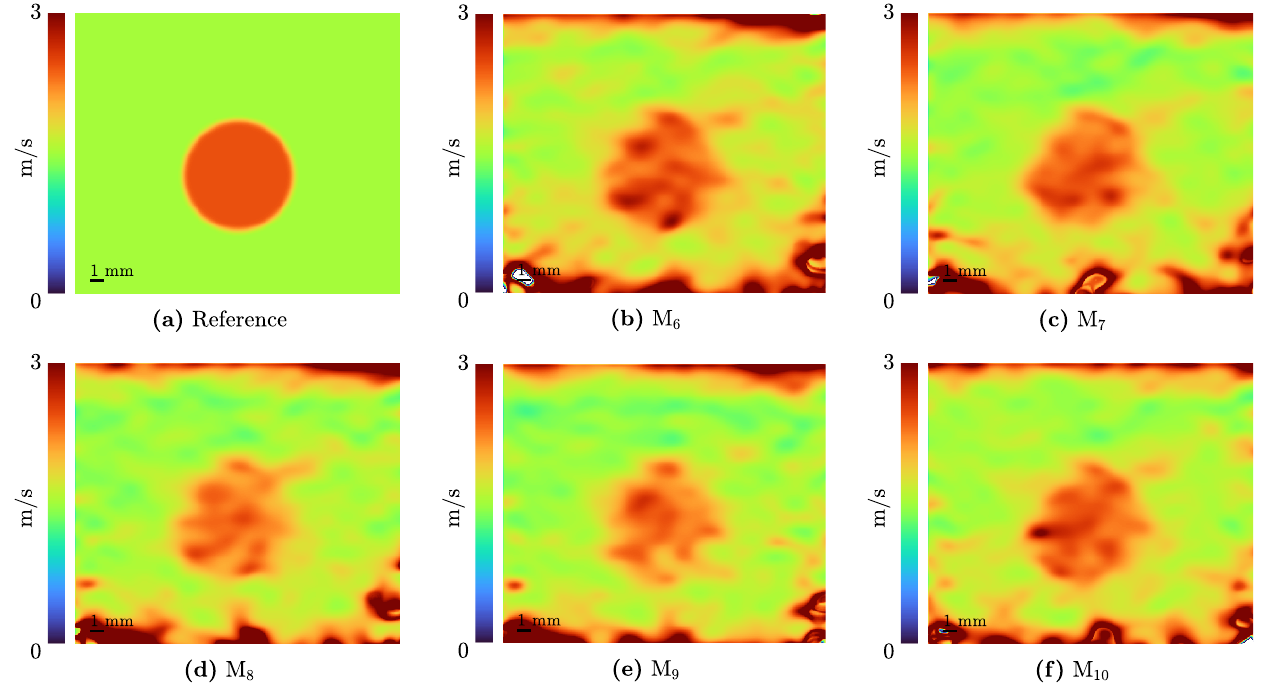
Figure 20. The results of the elastography algorithm of I 4 converted to the clinically used shear wave velocity c t